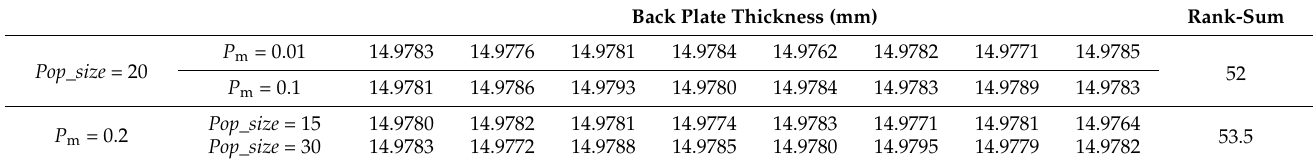
Table 4. Original sample data of back plate thickness at P c = 0.8. Back Plate Thickness (mm)